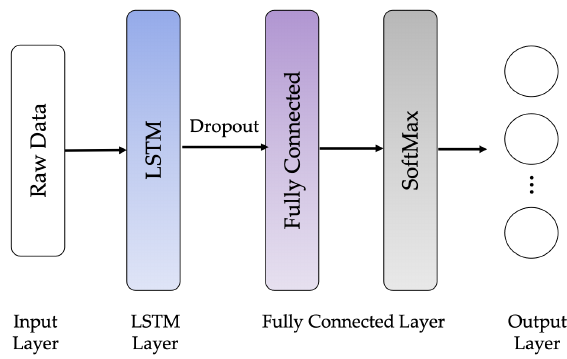
Figure 10. Vanilla LSTM network architecture.